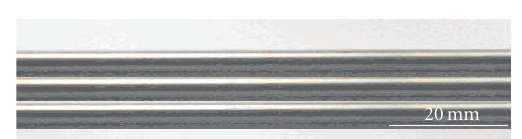
Figure 1: The image of AISI304 stainless steel pipes.